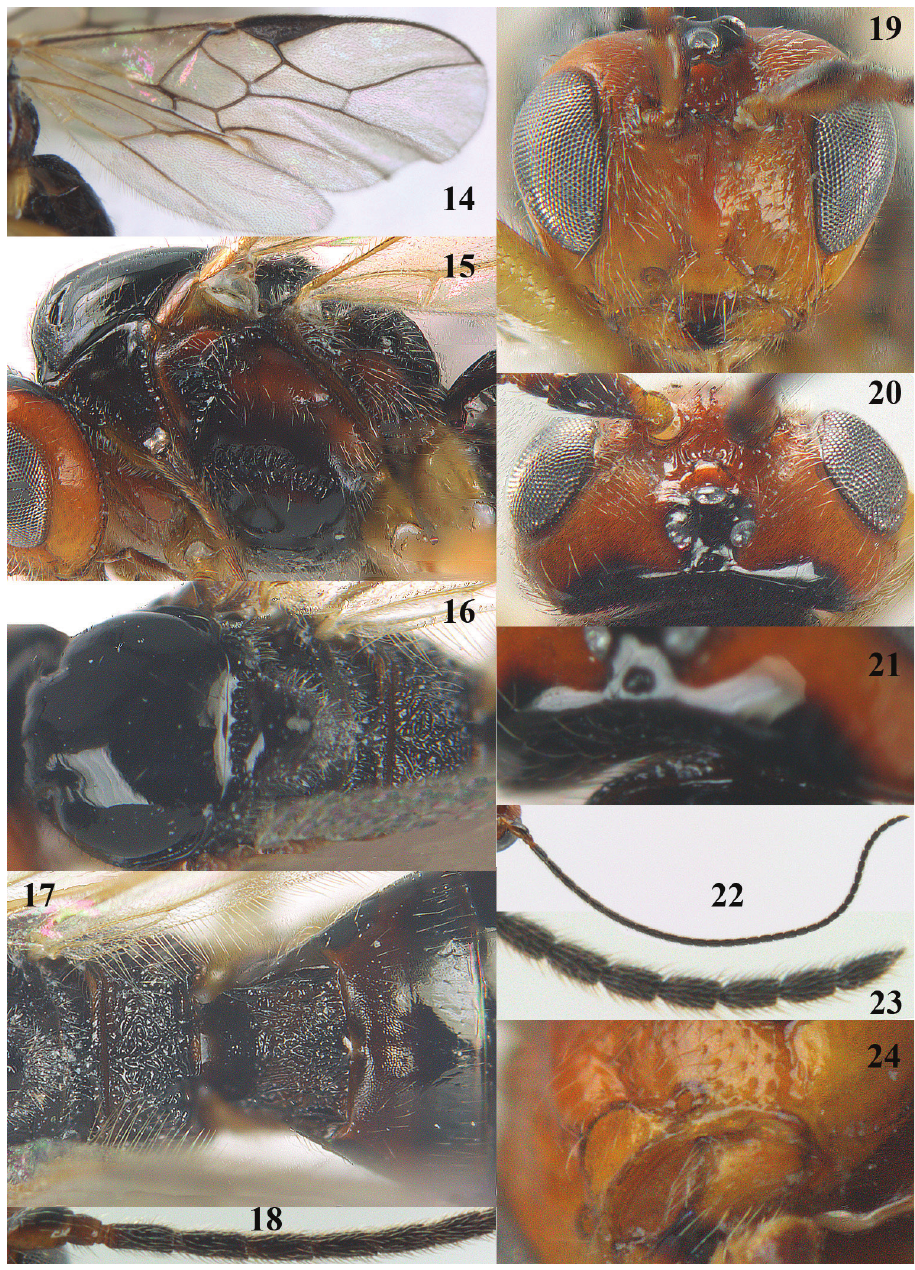
16 mesosoma dorsal 17 propodeum and first–third metasomal tergites dorsal 18 base of antenna 19 head anterior 20 head dorsal 21 detail of posterior part of head and pronotum dorsal 22 antenna 23 apex of antenna 24 mandible